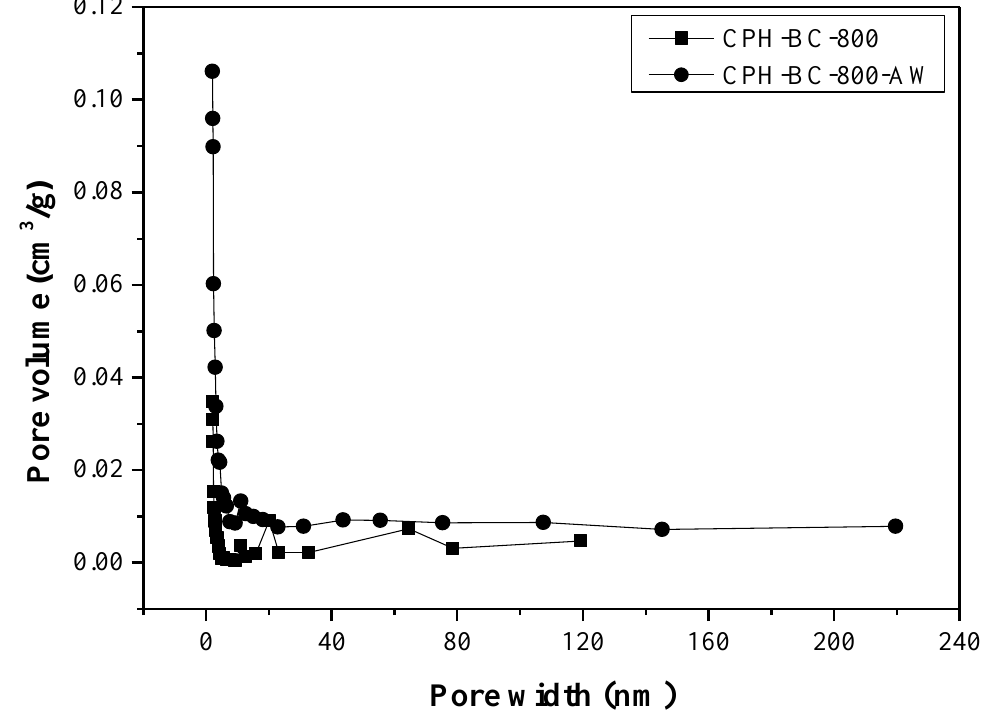
Figure 2. Pore size distributions of CPH-BC-800 products.